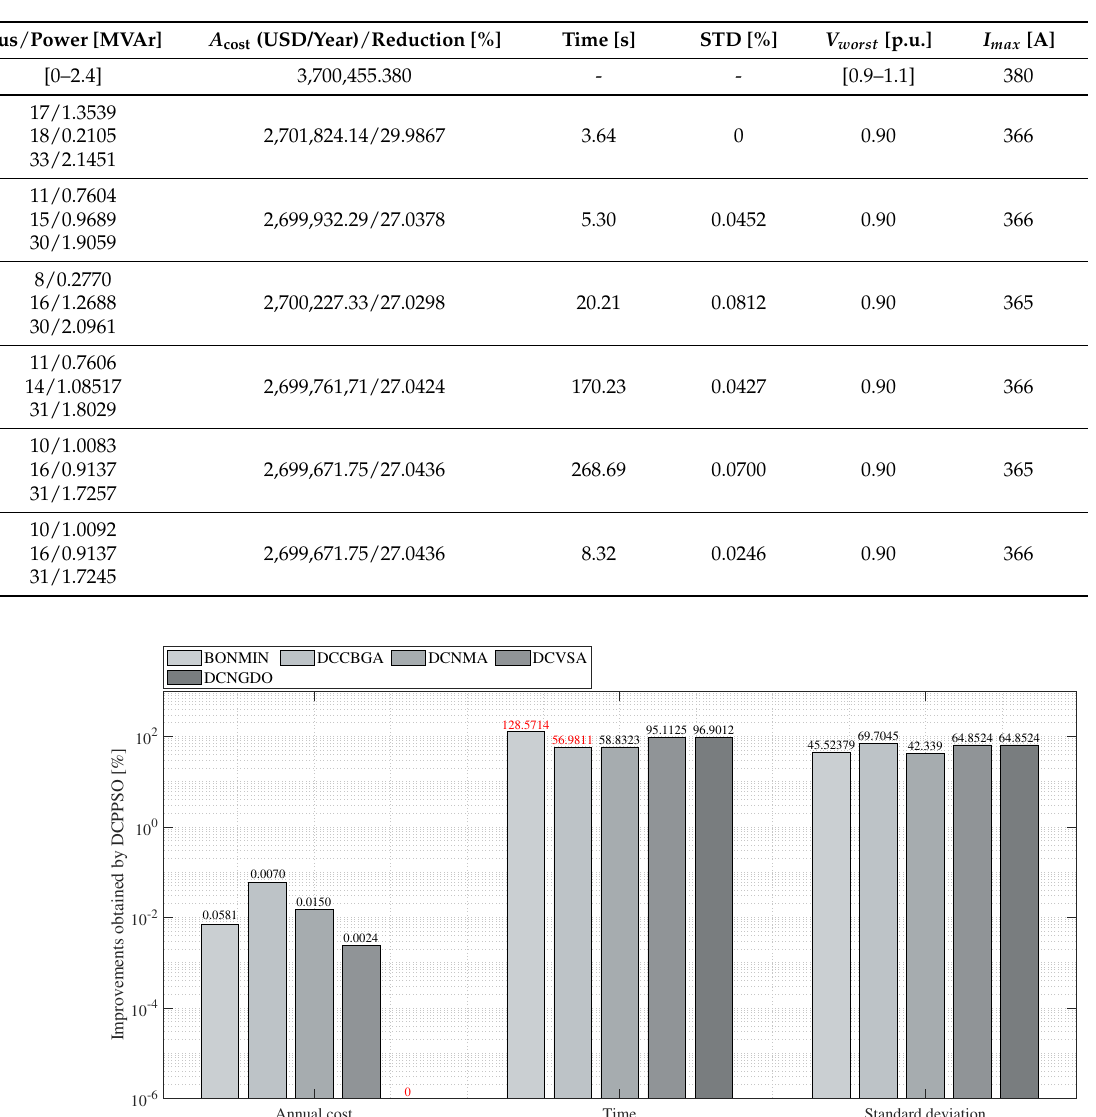
Table 4. Simulation results obtained by the solution methodologies in the 33-bus test system (AC and DC networks).